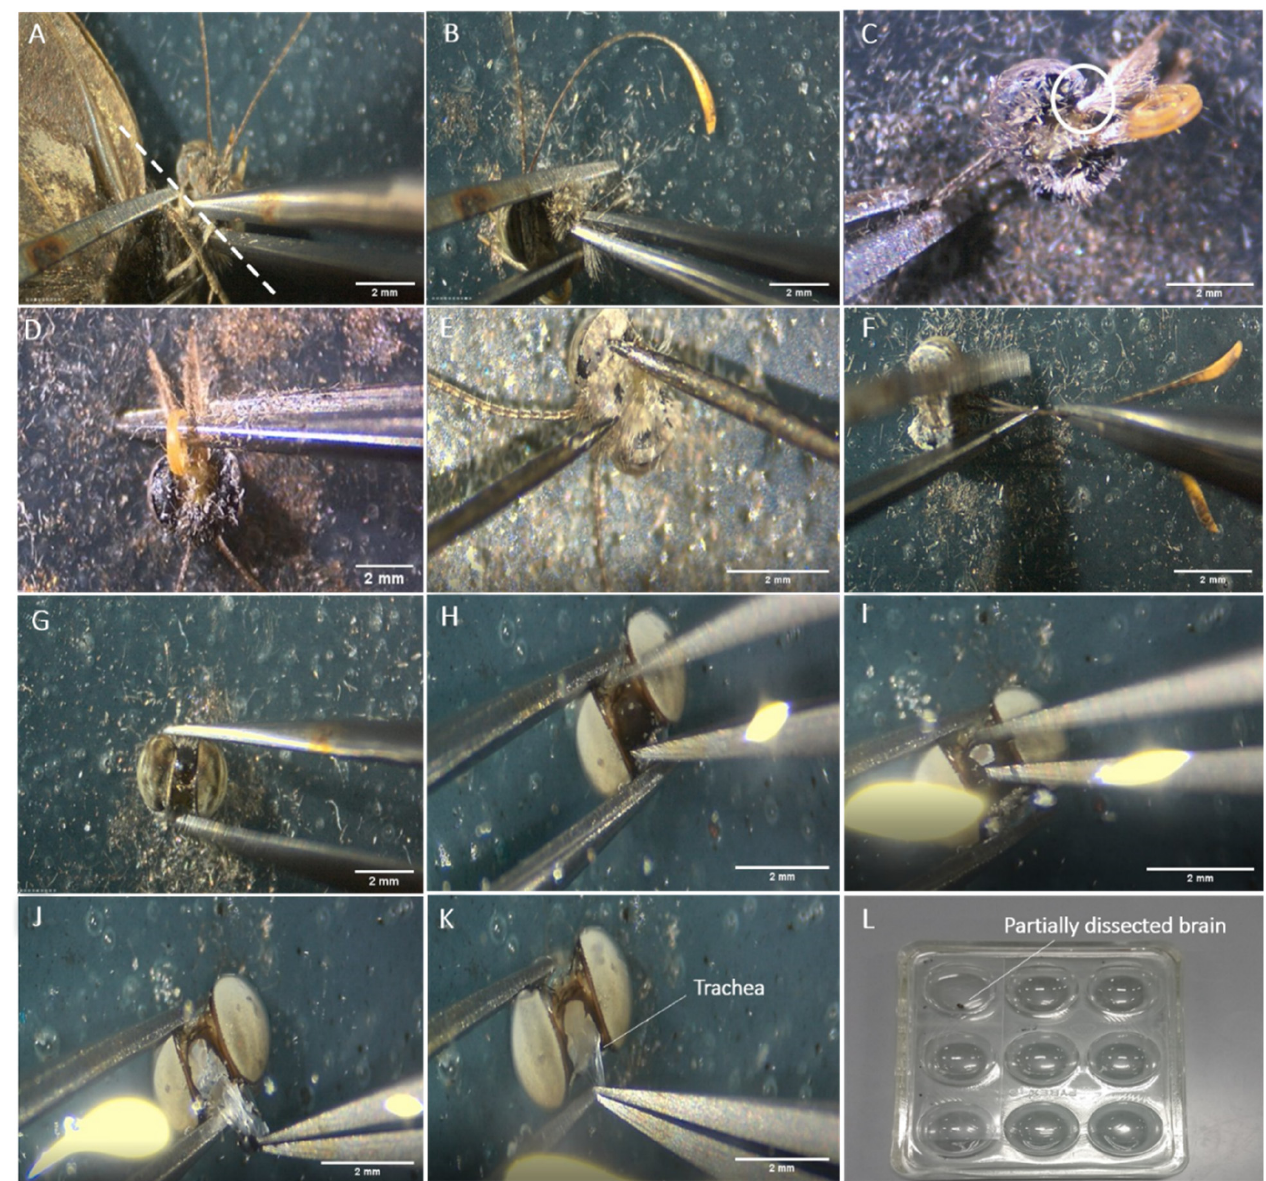
Figure 3. Exposure of an adult brain and fixation. Steps in ( A – G ) are performed dry while ( H – L ) are submerged in solution. ( A ) The ideal point of pull when detaching the head of the adult from the rest of the body is indicated by the white dashed line. ( B ) The remaining thoracic regions attached to the butterfly head are grabbed with fine forceps and pulled away. ( C ) The thoracic region is removed until the proximal ends of the palps are seen (circled in white). ( D ) The labial palps and the proboscis are then pulled away from the head. € The setae attached to the front and back of the cuticle are scraped off gently using insect pins, to prevent setae from clouding the surface of the dissecting solution in the later steps. ( F ) The antennae are subsequently removed. ( G ) The head is picked up gently using curved forceps and transferred to a dissecting plate with HBS. ( H ) The head is secured with curved forceps to allow easier access to the cuticle in between the two eyes (frontal view). ( I ) A small tear is made in the piece of cuticle in between the two eyes. ( J ) The brain is exposed with the region of the cuticle in between the two eyes removed, subsequently exposing the trachea underneath. ( K ) The sticky white trachea just below the surface of the cuticle are removed. ( L ) The exposed brain is submerged in a ZnFA solution in a spot plate well, and the opening is covered with a glass slide to prevent evaporation of the solution and drying of the tissues. The glass plate is subsequently placed on an orbital shaker with a setting of 80–100 rmp for 16–20 h.